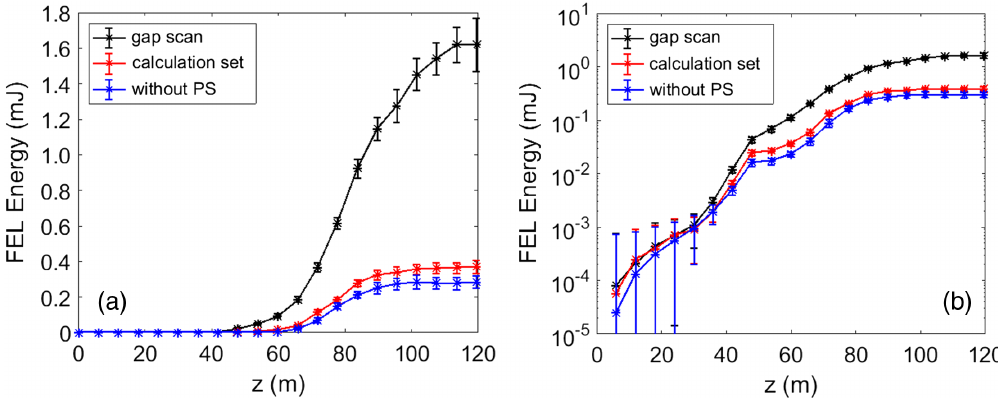
FIG. 8. Comparisons of the gain curve in (a) linear and (b) log scale; bars, (cid:4) 1 s : d : ; n ¼ 100 . The black line is obtained from the phase-shifter gap scans, the red line is setting the phase-shifter gap by calculations using Eq. (16), and the blue line is without the phase-shifter